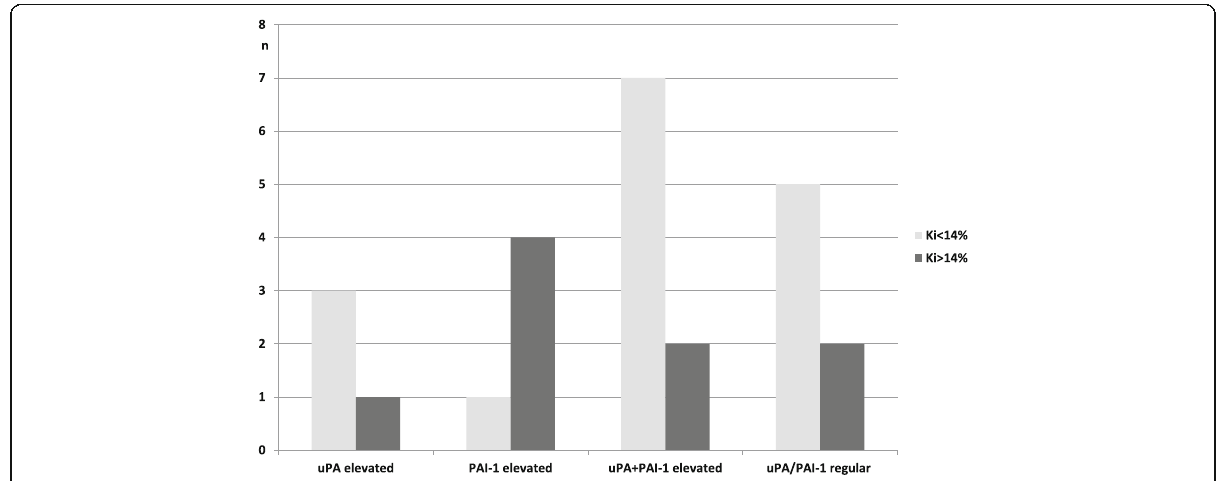
Fig. 4 Number of cases with Ki67-Index low (< 14%) and elevated (> 14%) together with results of uPA and